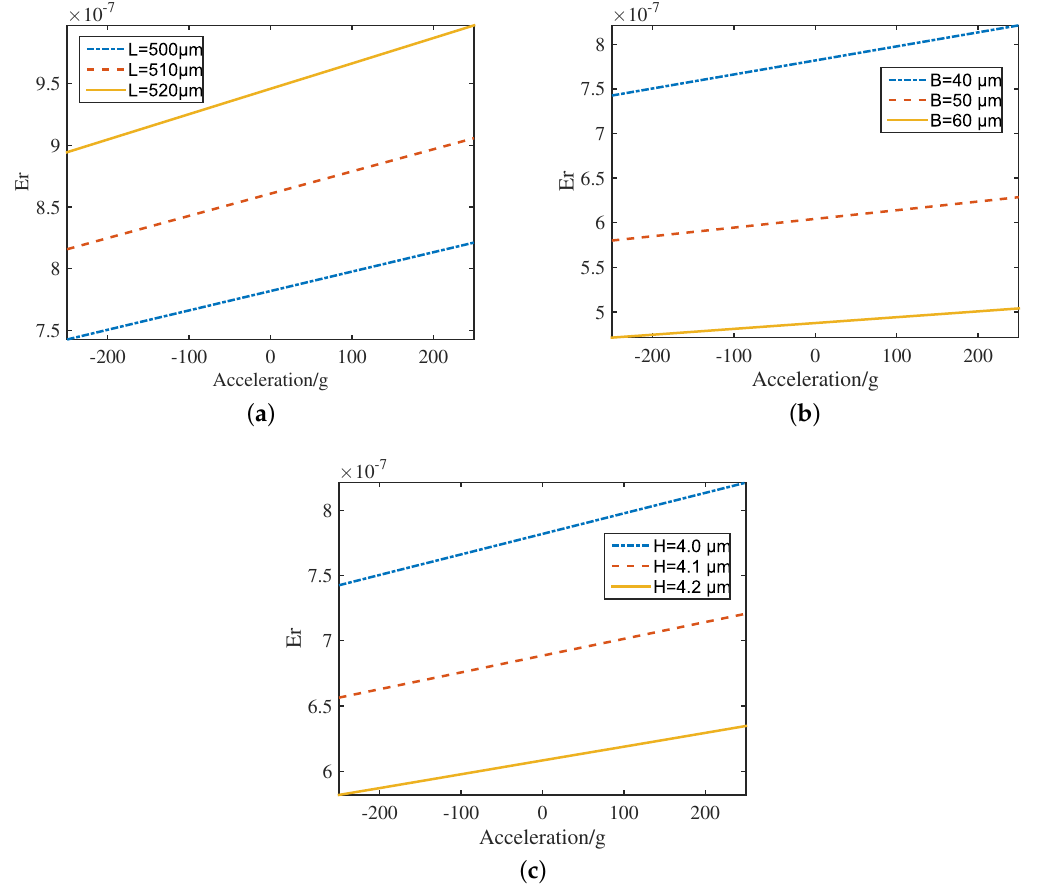
Figure 4. The natural frequency-tracking error with ( a ) length, ( b ) width and ( c ) thickness in accelerometer caused by nonlinear vibration ( Q = 10,000, U p = 0.50 V, U d = 0.05